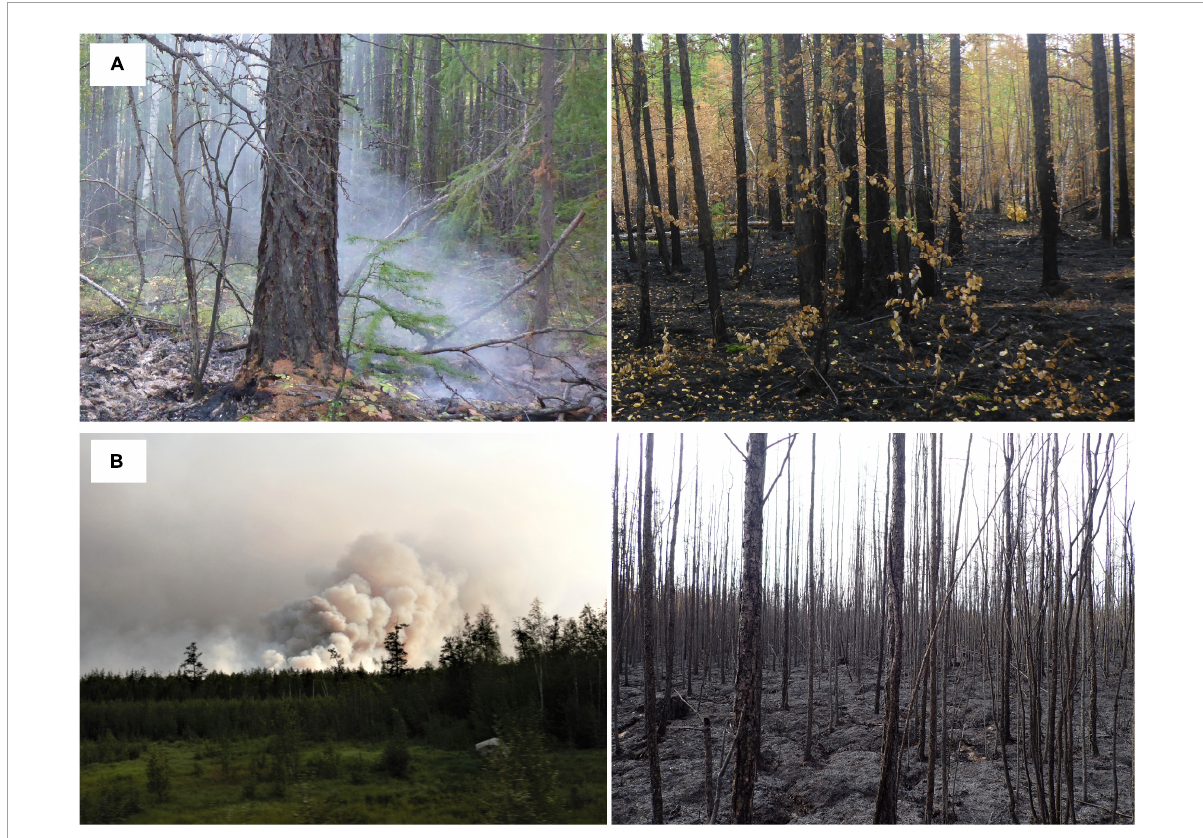
FIGURE8 (A) Photos of a low-severity surface fire plume and its impact near Nyurba and Lake Satagay in August 2019 (S. Stünzi and E. Dietze, AWI). (B) Photos of a high-severity fire plume and its impact near Ytyk-Kyuyol (c. 200 km east of Yakutsk) in August 2021 (R. Jackisch and R. Glückler,